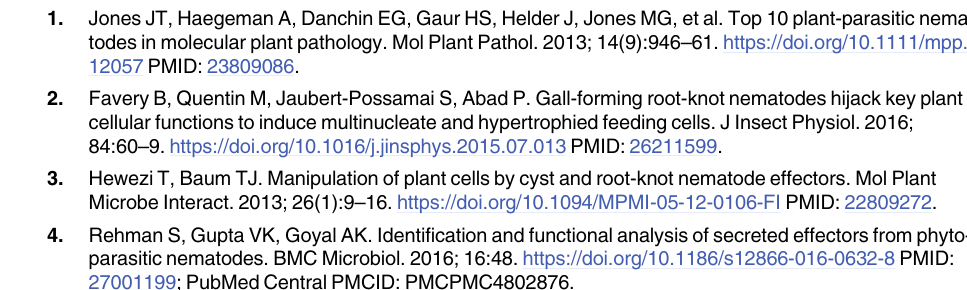
S1 Table. Primers used in this